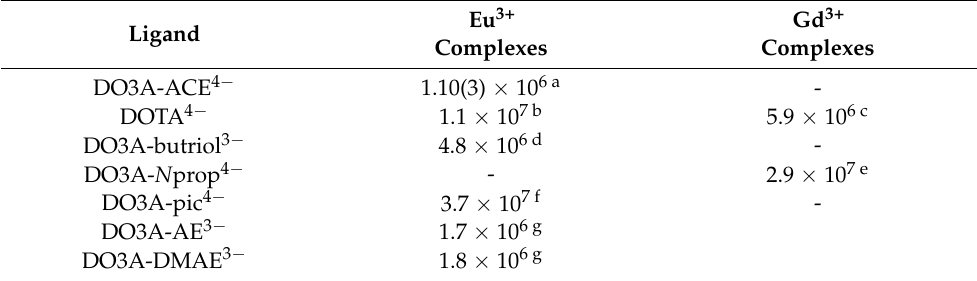
Table 4. Rate constants k OH (M − 1 s − 1 ) characterizing the formation of Eu 3+ and/or Gd 3+ macrocyclic complexes (25 ◦